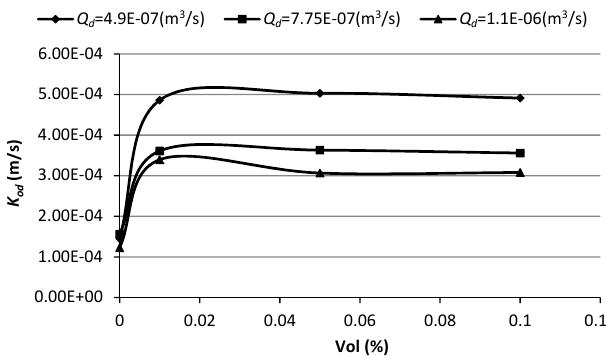
Fig. 4. Variation of mass transfer coefficient with concentration of TiO 2 .